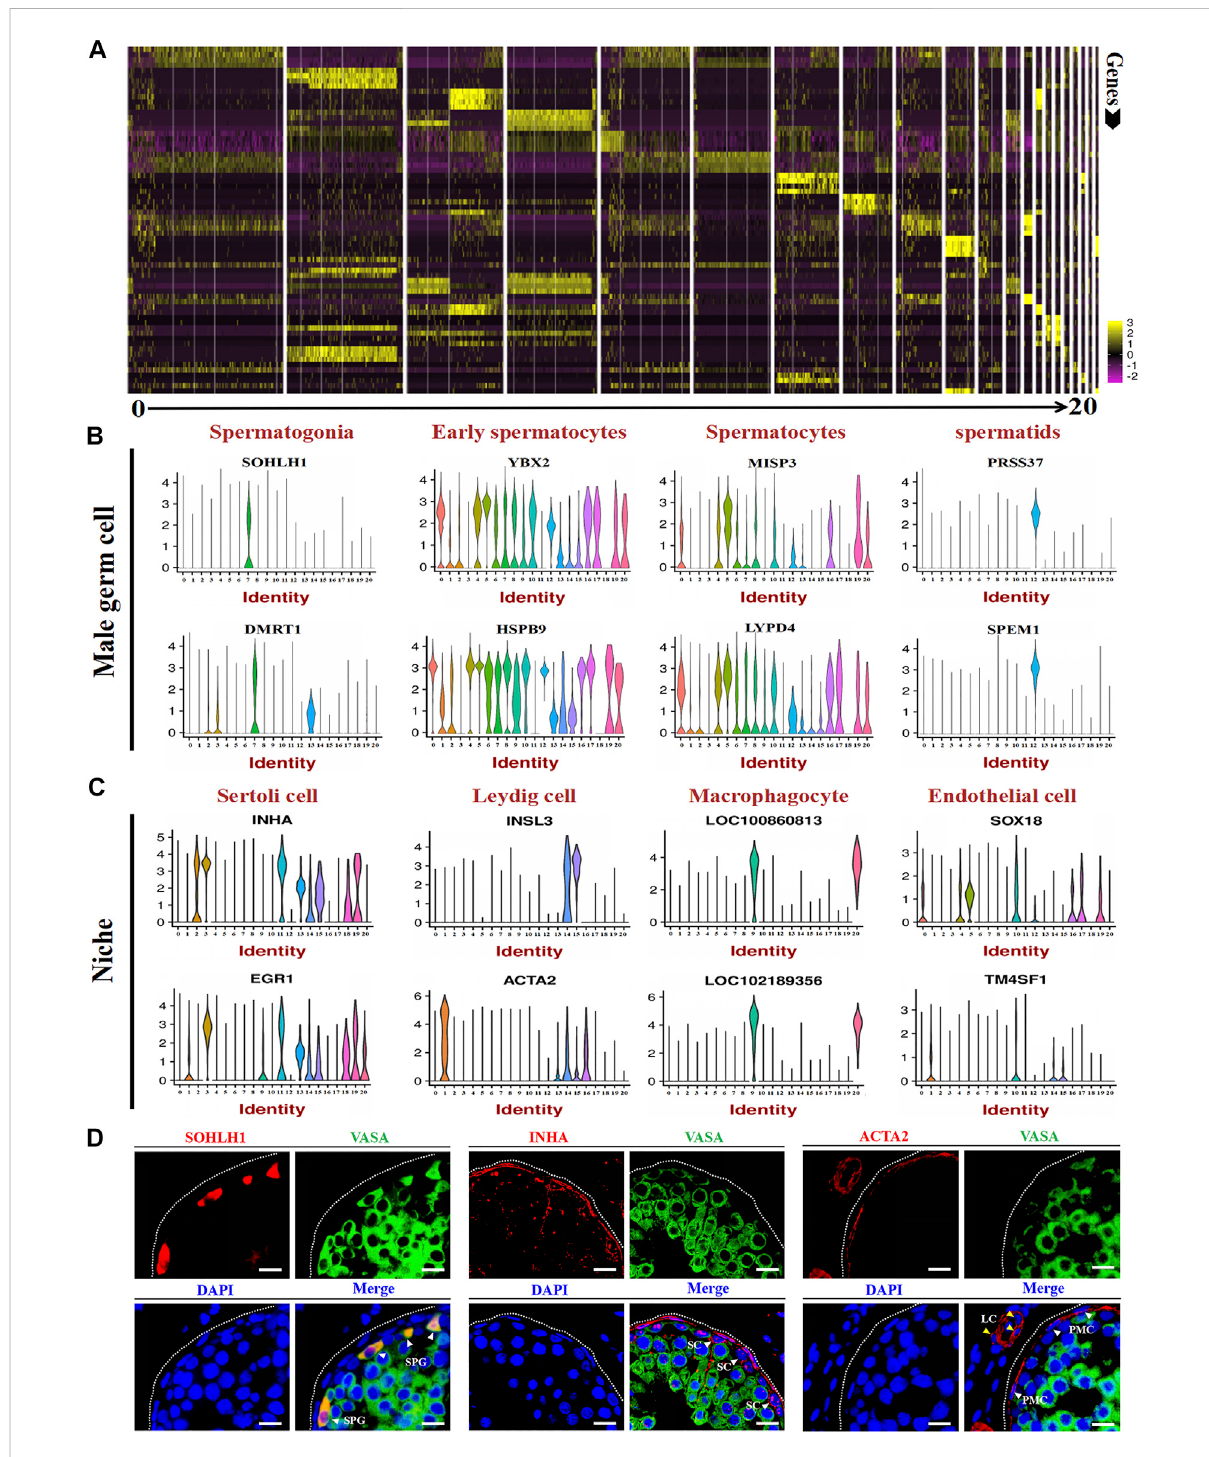
FIGURE 4 Marker gene identi fi cation of each testicular cell type. (A) Heatmaps show the top 4 signi fi cantly differentially expressed genes between each cell cluster for testicular cells. (B,C) Expression patterns (violin plot) of each cell speci fi c gene across the different cluster. (D) Immuno fl uorescence analysis the expression location of SOHLH1, INHA, and ACTA2 in dairy goat testes. Three potential markers (SOHLH1, spermatogonia; INHA, Sertoli cells;ACTA2,testicularsomaticcells)andmale germcellmarker(VASA)werestainedinadulttestistissuesections,respectively.TheDAPI(blue) denotes nuclei. SPG, spermatogonia. SC, Sertoli cell. LC, Leydig cell. PMC, peritubular myoid cells. Bar = 10 μ